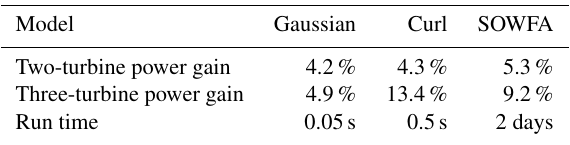
Table 1. Power percentage improvements for the cases with and without steering for the Gaussian model, curled wake model, and